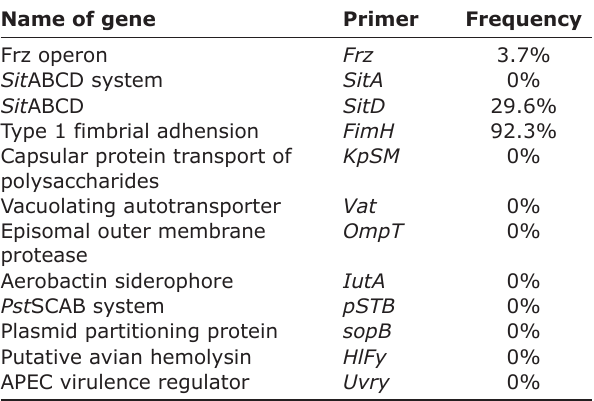
Table-1: Percentage frequency of virulence genes in AFEC from ducks. Name of gene